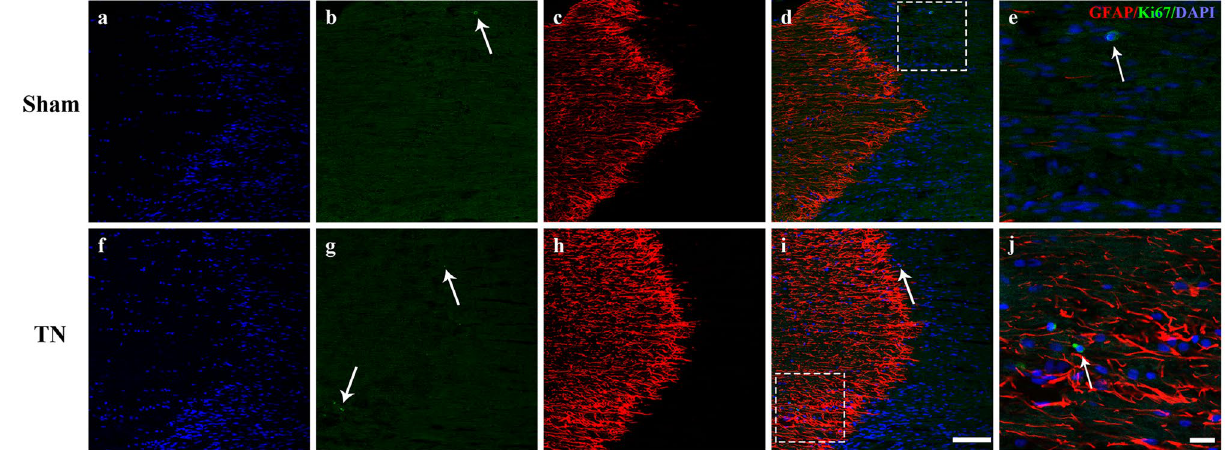
Figure 4. Immunofluorescence staining of GFAP, Ki67 and DAPI in the TREZ on POD 28. ( a – e ) and ( f – j ) show that the representative Ki67/DAPI-positive cells (white arrow) in the TREZ in two groups were both small, scale bar = 100 μm. ( e ) and ( j ) show the Ki67/DAPI-positive cells at higher magnification, scale bar = 25 μm.